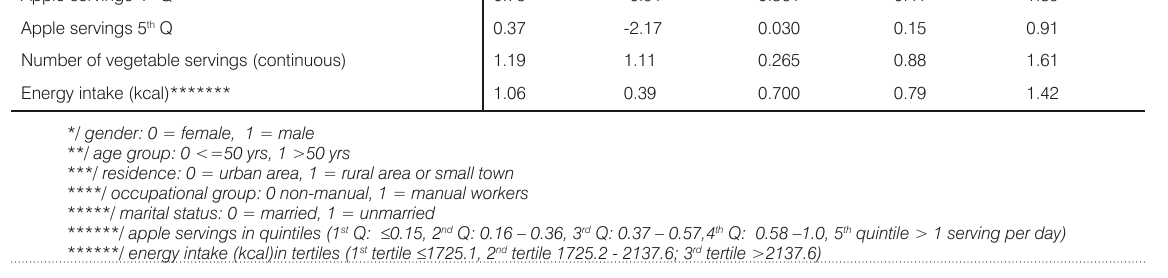
Figure 1. Predicted colorectal cancer risk (OR with 95% CI) and the number of apple